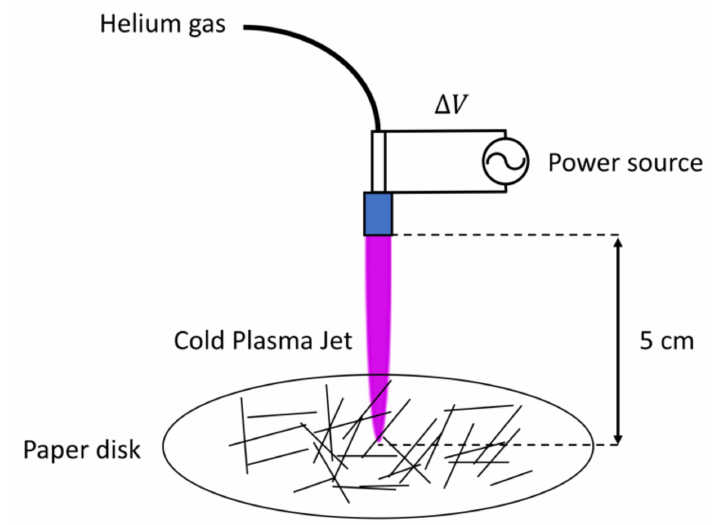
Figure 3. Cold plasma treatment